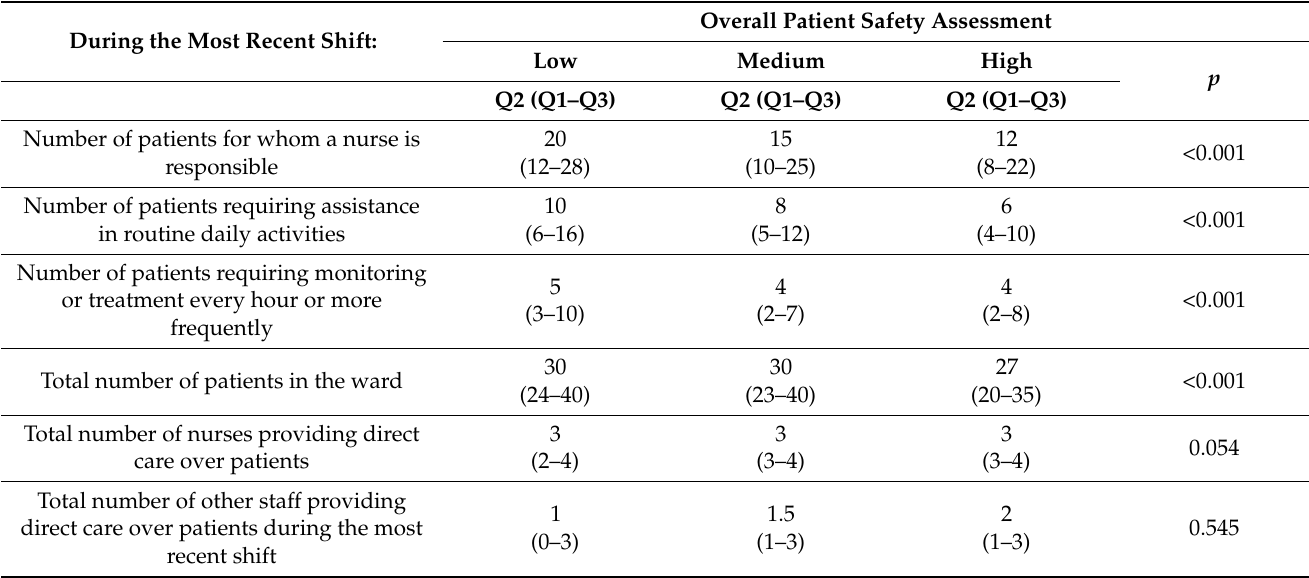
Table 4. Patients’ safety and nurses’ workload during their most recent